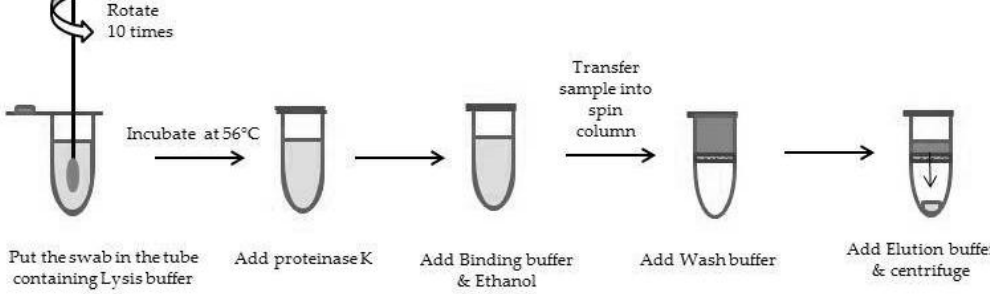
Figure 1. Buccal swab DNA extraction with silica membrane.